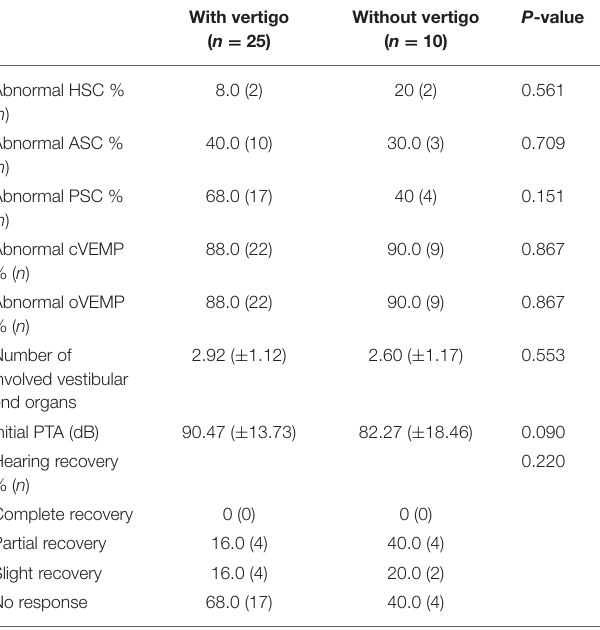
TABLE 2 | The audio-vestibular tests in the patients with profound sudden sensorineural hearing